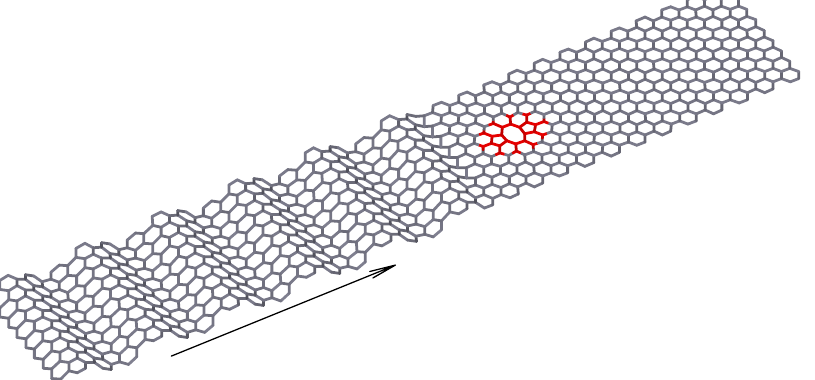
Figure 1. Schematic of the scattering of a longitudinal monochromatic wave by a double-vacancy V 2 (585) defect in an armchair graphene nanoribbon. Region of the defect is marked by a color. An arrow shows the direction of the wave